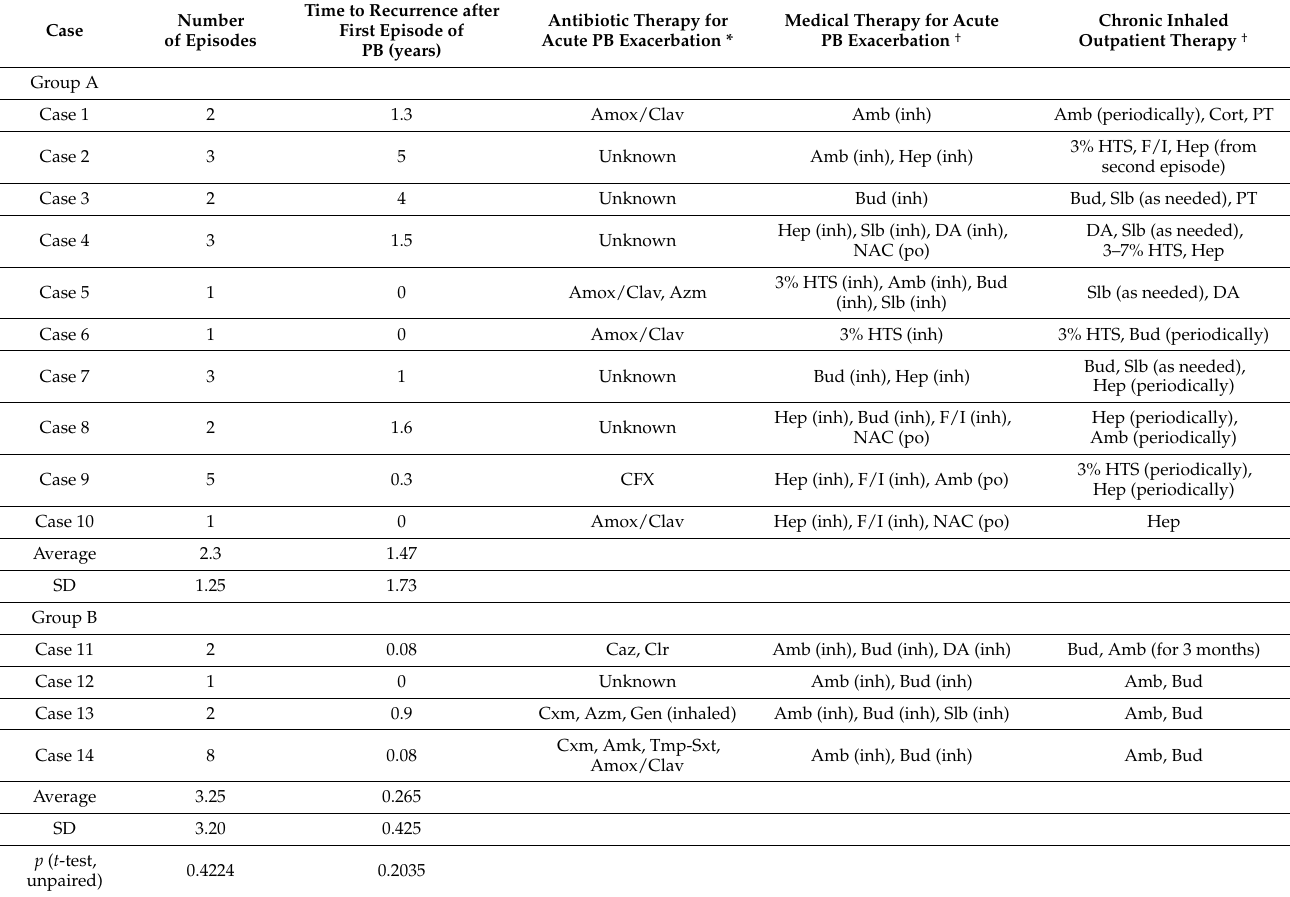
Table 4. Recurrence characteristics in patients with plastic